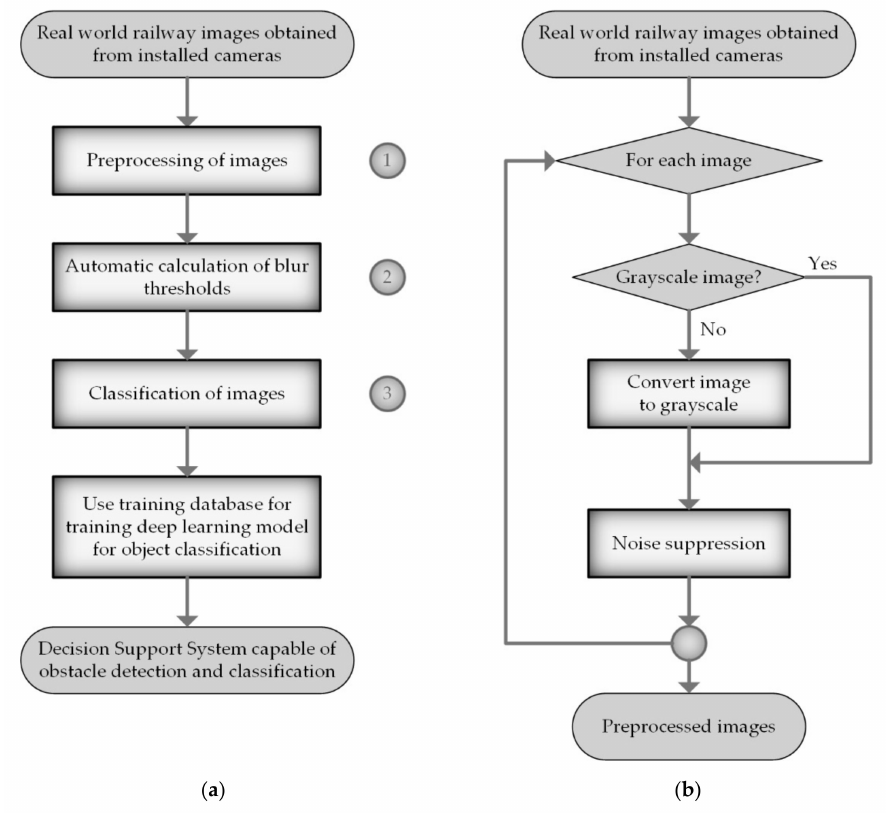
Figure 3. Proposed algorithm: ( a ) overall flow chart of the proposed algorithm; ( b )